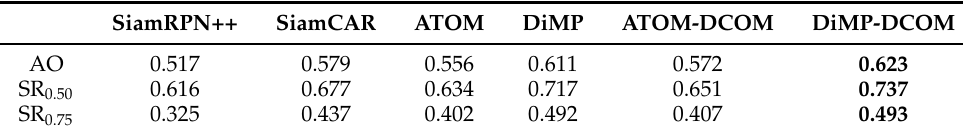
Table 5. Comparisons with the state-of-the-art trackers on GOT-10k.